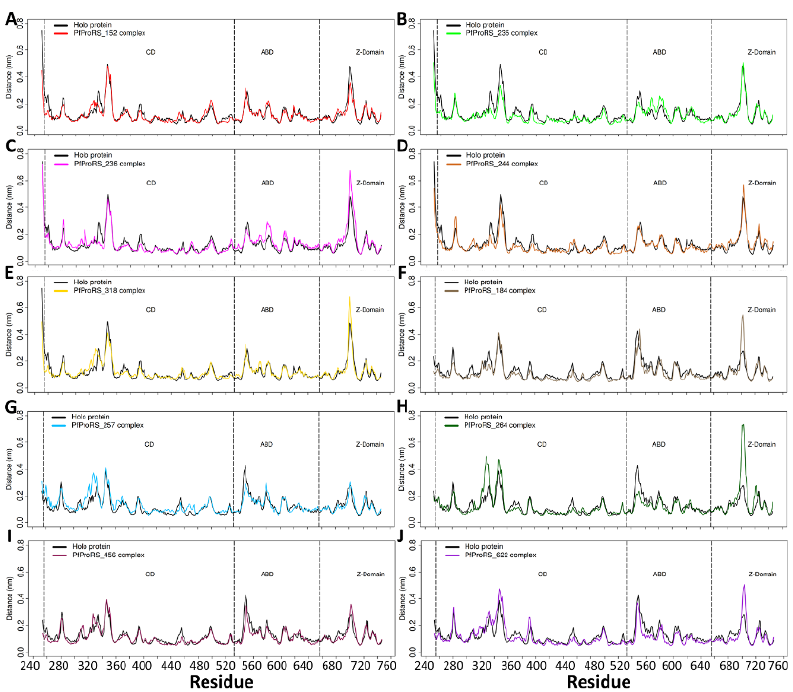
Figure 8. Per residue root mean square fluctuation analysis of the holo system and PfProRS ligand-complexes during the 200 ns simulation. ( A ) PfProRS-SANC152 complex, ( B ) PfProRS-SANC235 complex, ( C ) PfProRS-SANC236 complex, ( D ) PfProRS-SANC244 complex, ( E ) PfProRS-SANC318 complex, ( F ) PfProRS-SANC184 complex, ( G ) PfProRS-SANC257 complex, ( H ) PfProRS-SANC264 complex, ( I ) PfProRS-SANC456 complex and ( J ) PfProRS-SANC622 complex.